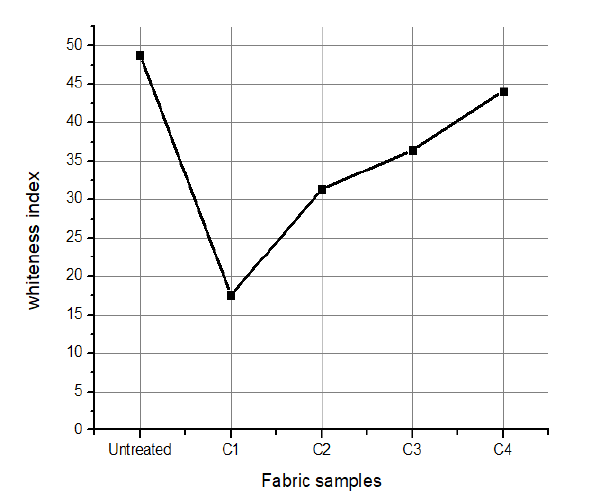
Fig. 2. Graphical representation of assessment of